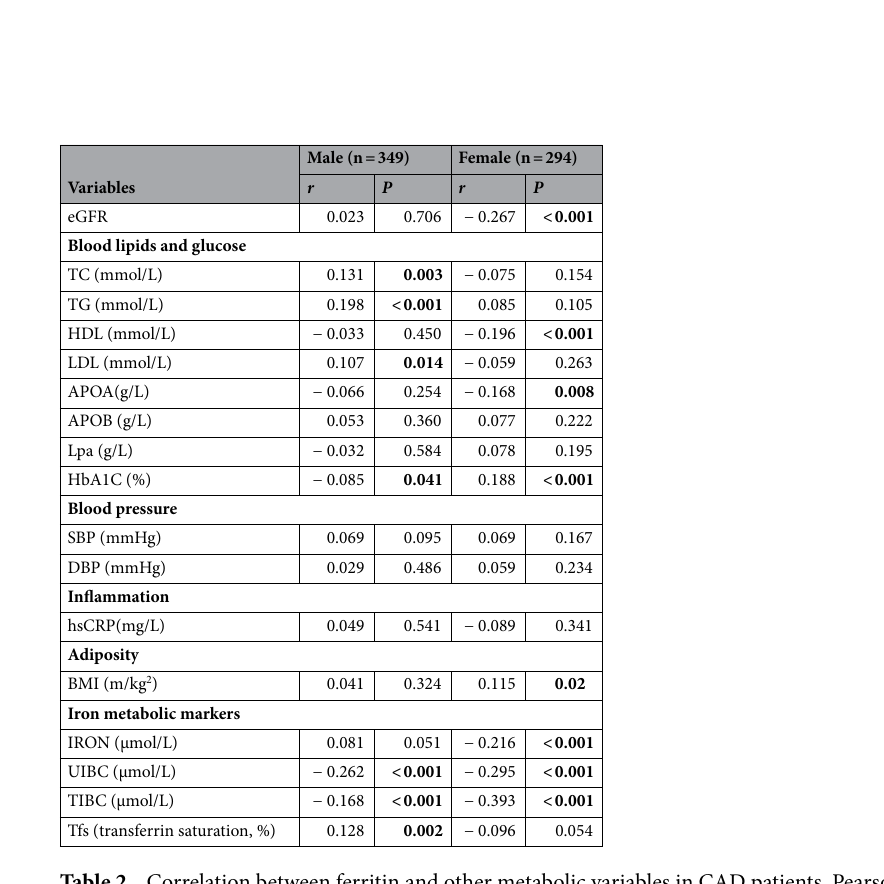
Table 2. Correlation between ferritin and other metabolic variables in CAD patients. Pearson correlation was performed with ferritin and other metabolic variables in CAD patients. Continuous variables with skewed distributions (ferritin, TG, hs-CRP) were log transformed for analysis. Bold values indicate significant results with P < 0.05. eGFR estimated glomerular filtration rate, BMI body mass index, HbA1c glycosylated haemoglobin, TC total cholesterol, LDL-C low-density lipoprotein cholesterol, HDL-C high-density lipoprotein cholesterol, TG triglycerides, SBP systolic blood pressure, DBP diastolic blood pressure, hs-CRP high sensitive C-reactive